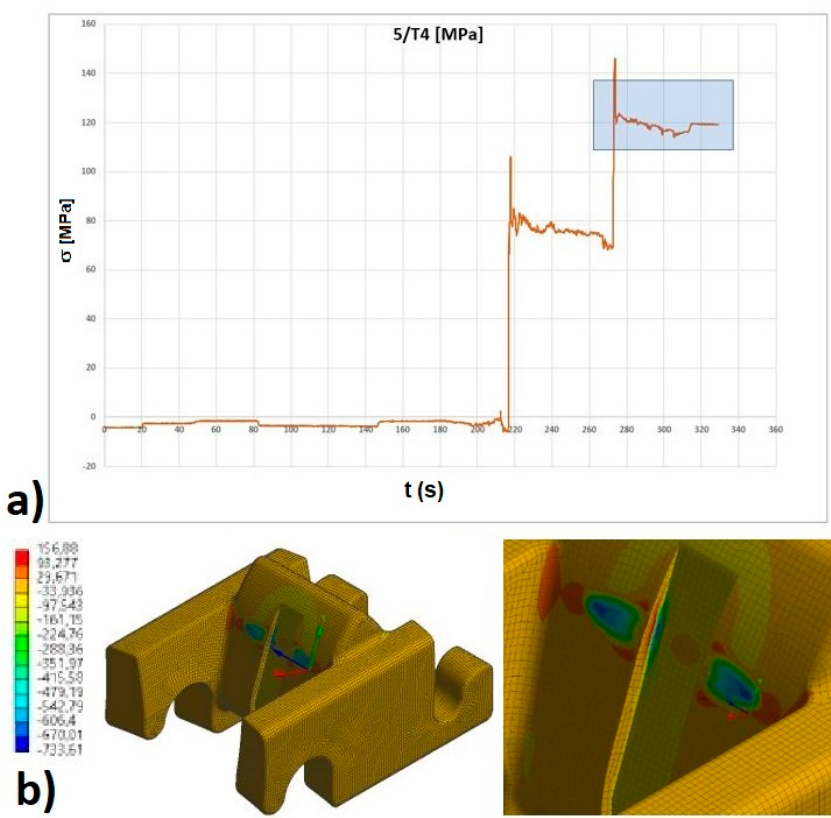
Figure 19. Values of main stresses in the contact place of the track wheel with the toothed segment with four glued strain gauges: ( a ) result of conducting strain gauge tests, ( b ) result of the FEM simulation.